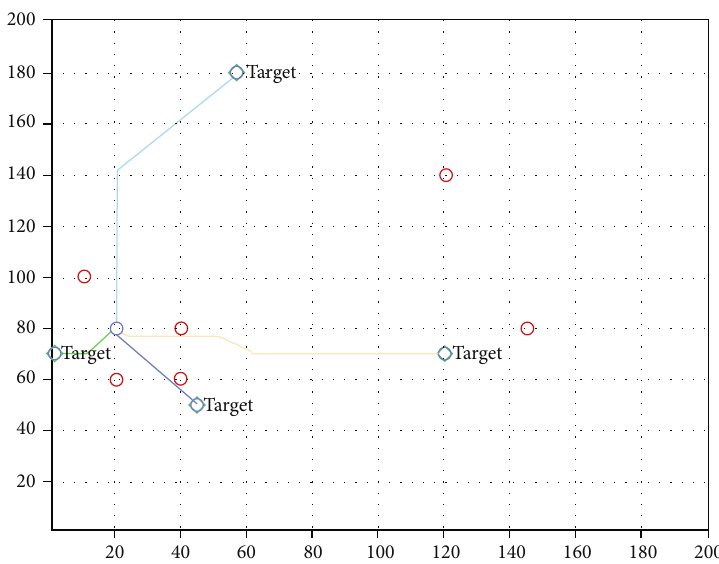
Figure 6: UAV swarms searching the environment for four ranges and four targets.